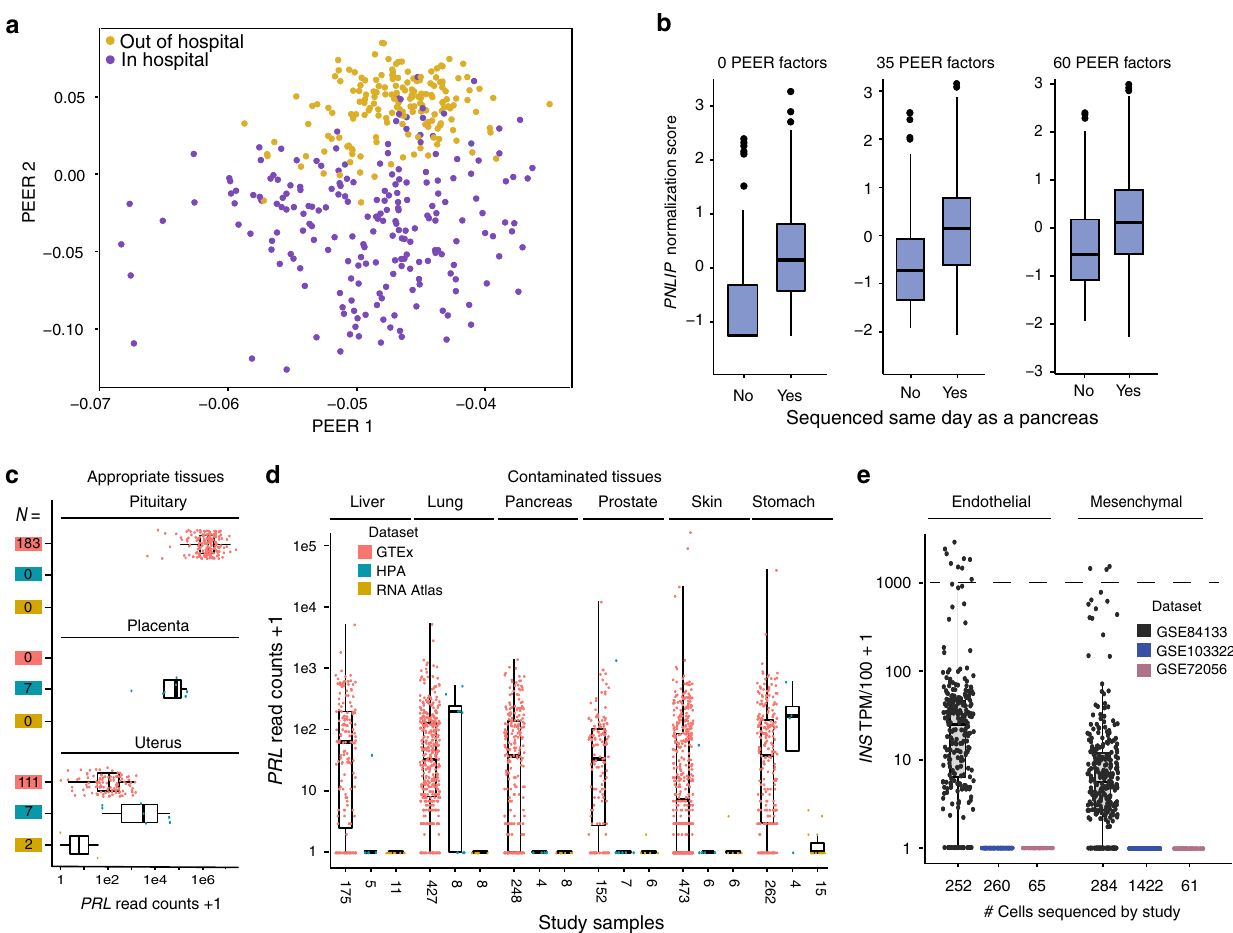
Fig. 3 Impact of PEER factors on contamination and differing contamination outcomes by study. a The top two PEER factors separated in hospital from out of hospital deaths ( N = 427). b With no PEER factor correction there is a signi fi cant increase in PNLIP expression normalized scores in lung samples if they were sequenced on the same day as a pancreas (no = 96, yes = 331; linear regression, p = 4.34e-14). After 35 ( p = 1.38e-11) or 60 ( p = 3.03e-06) PEER factor corrections, the difference remained. The solid line in all boxplots represents the median of the data, whereas the lower and upper hinges correspond to the 25th percentile and 75th percentile, respectively. The whiskers represent the interquartile range × 1.5, and any outliers beyond the whiskers are represented as dots. c Prolactin (PRL) read counts in pituitary (high), placenta (medium), and uterus (low), where PRL is known to be expressed across GTEx, HPA, and the RNA Atlas. The numbers in colored boxes indicate sample sizes and the color indicates respective study. d PRL contamination reads across six tissues from three studies that correlate with levels of likely contamination based on the other sequenced organs. e INS contamination across three scRNA-Seq data sets. Only in the pancreas data set (GSE84133), where beta cells were also sequenced, does INS appear to be lowly expressed in endothelial and mesenchymal cells. Cells with expression above the dotted line at 1000 TP10K are likely doublets or multiplets. Table 3 Signi fi cance of same-day sequencing of lung with contaminating tissues on gene expression.